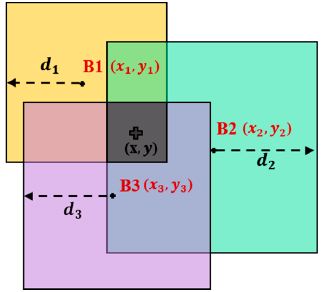
Figure 3. The bounding box method.